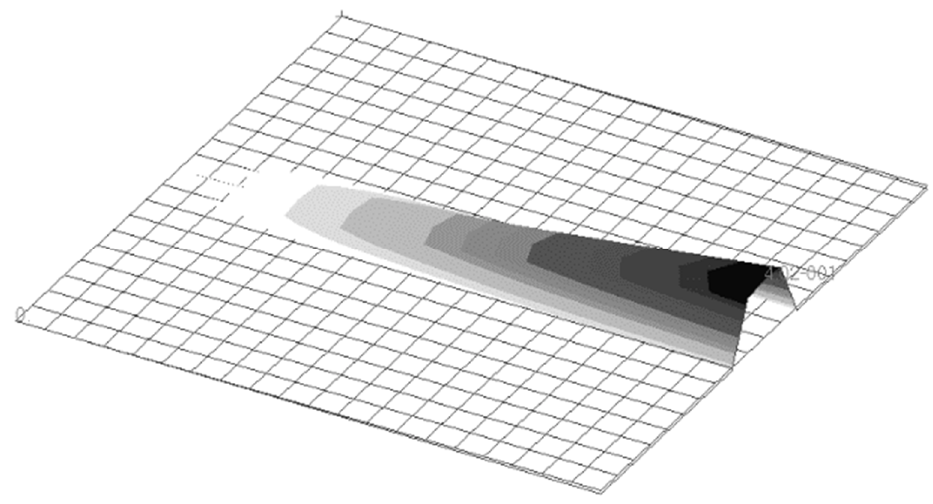
Figure 9. Static nodal displacement of the optimized model.